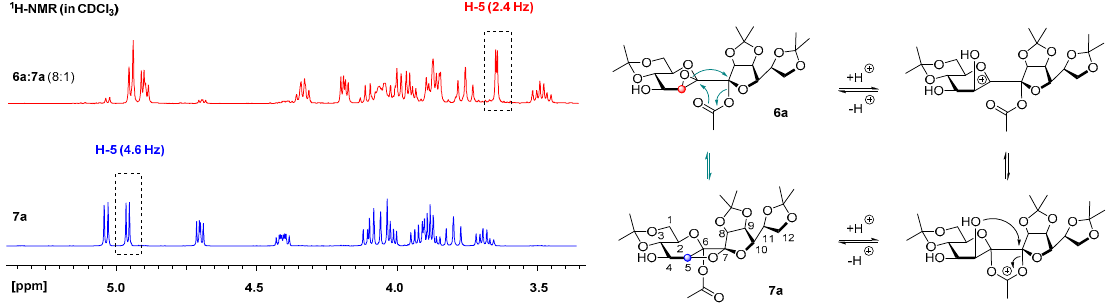
Figure 1. Proposed mechanisms for the rearrangement from epoxide 6a to oxetane 7a and their 1 H-NMR spectra in CDCl 3 to illustrating the reaction progress.